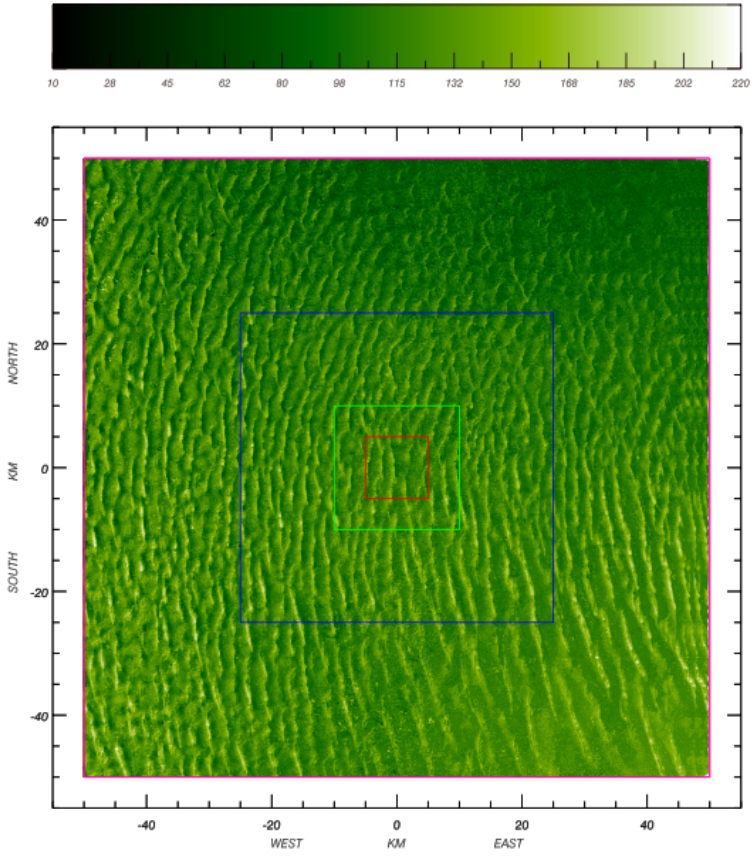
Figure 1. ASTER DEM over the Libya-4 area with the four ROIs used in this study: 10 km × 10 km (red line), 20 km × 20 km (green line), 50 km × 50 km (blue line) and 100 km × 100 km (magenta line). Altitudes are provided in